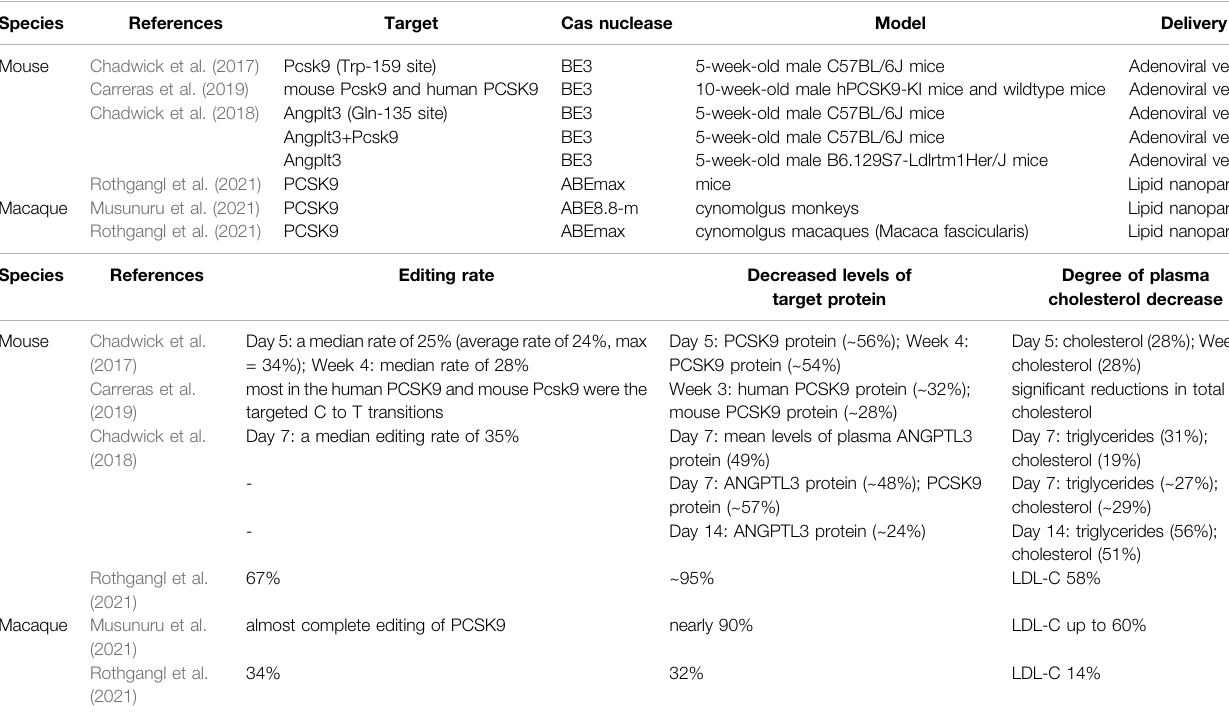
TABLE 2 | Experimental studies of base editing for RH.